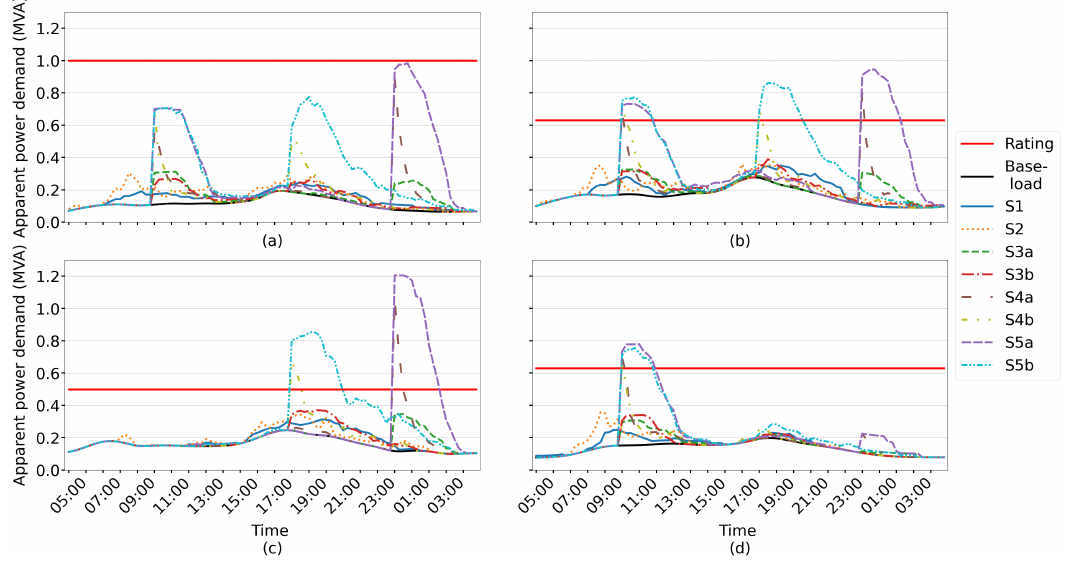
Figure 8. Transformer loading illustrated for a period of 24 h starting at 05:00 on 6 January 2020. Four different 10/0.4 kV transformers are presented, illustrating a: ( a ) no-overload scenario; and congestion scenarios caused by ( b ) both work and home charging; ( c ) solely home charging; and ( d ) solely workplace charging. Transformer ratings and the baseload are indicated by red and black lines. Colored lines in different shapes indicate the aggregated apparent power demand (baseload + EV demand) in each